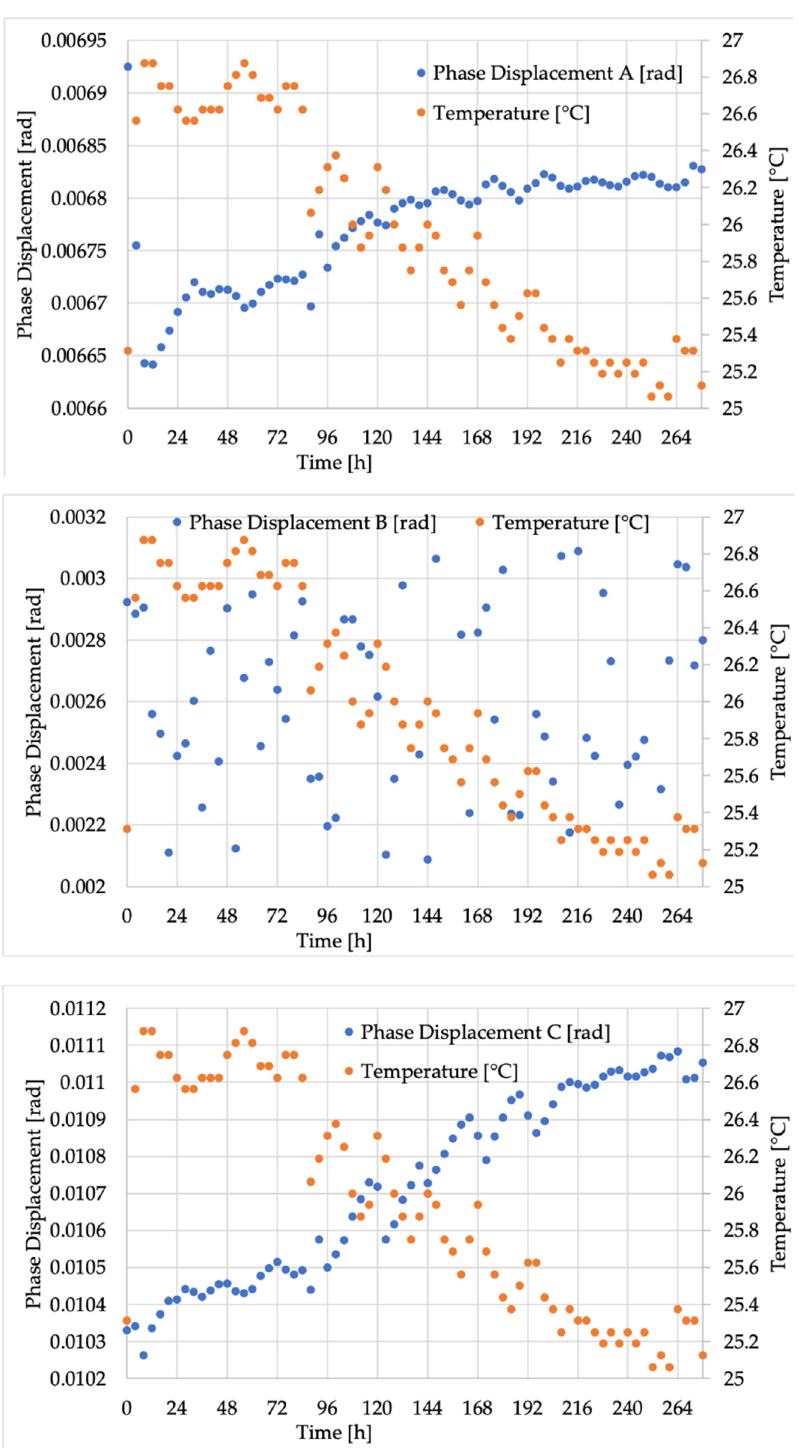
Figure 4. Ratio error results for VTs ( A – C ) (from top to bottom).